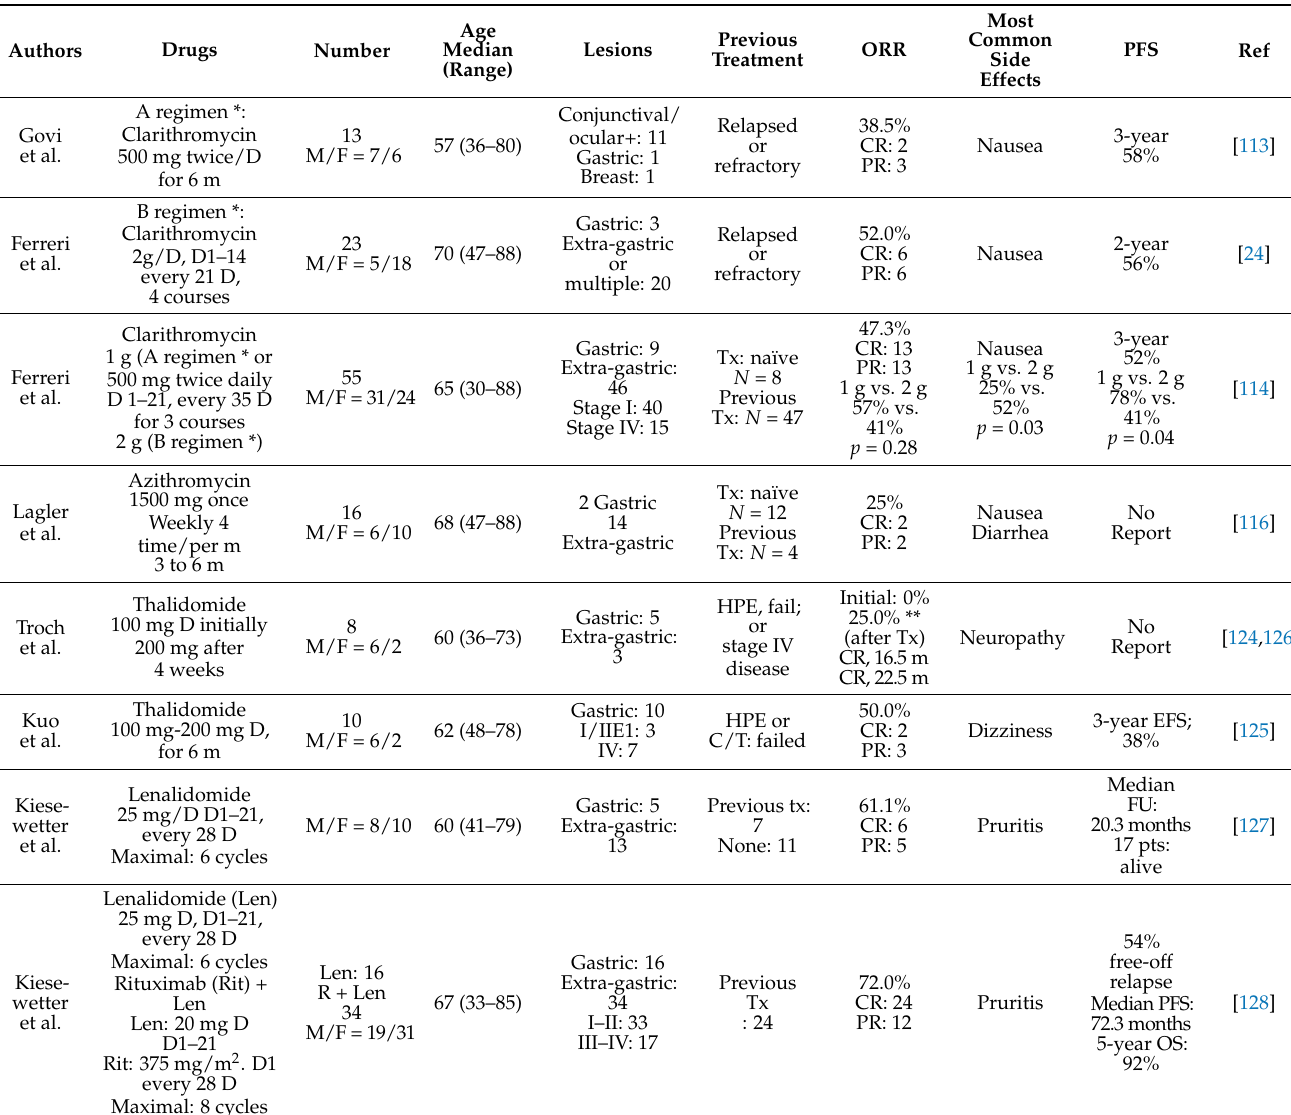
Table 2. Summaries of the therapeutic efficacies of immunomodulatory drugs in relapsed or refractory MALT